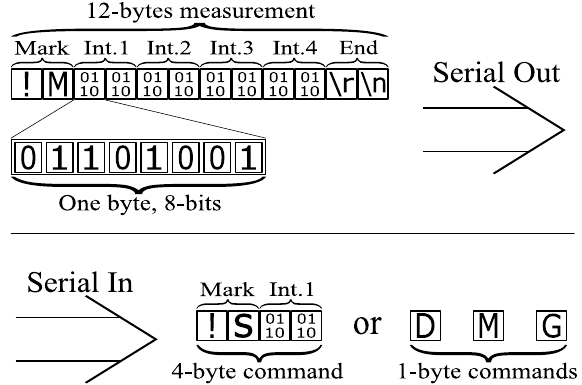
Figure 4. Serial data package configuration; the upper half shows package configuration when sent from the MCU to the PC and the lower half shows the reversed case. Implemented commands are: S, Send new settings to MCU; D, Download current settings from MCU; M, continuously stream Measurements and return values as binary code; B, Break binary stream; and G, Get last measurement; and return values as